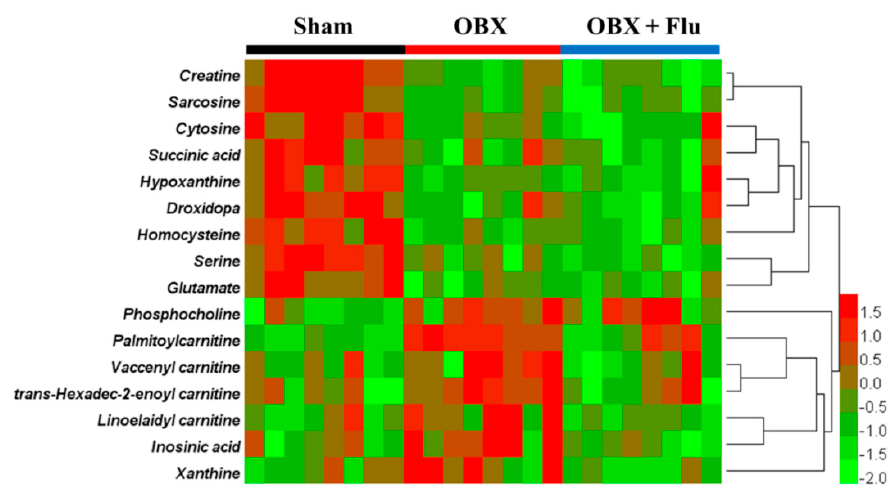
Figure 6. Heat map of identified biomarkers in the hippocampus of OBX rats. Red and green represent that the levels of potential biomarkers are higher and lower compared to the average level, respectively. Rows imply the potential biomarkers and columns represent hippocampus samples of rats ( n = 8 in each group). Flu, fluoxetine. OBX, olfactory bulbectomy.